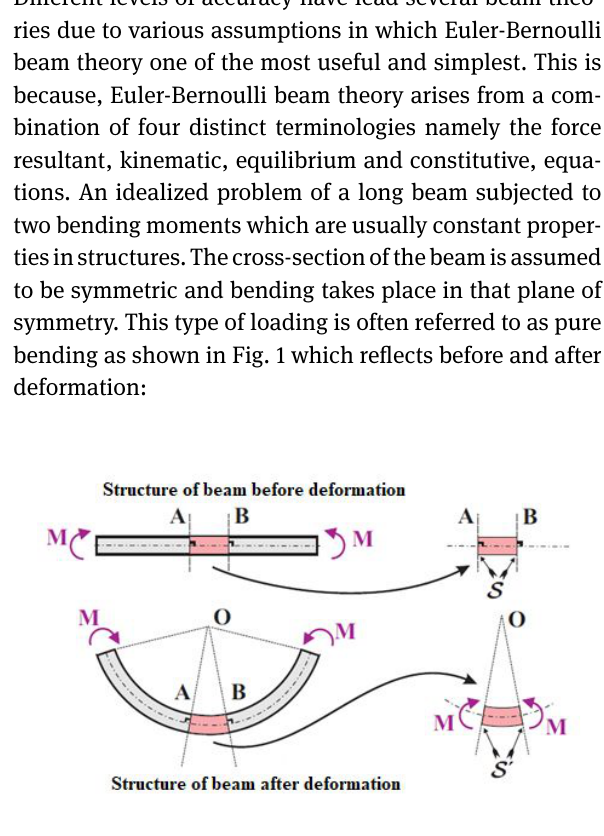
By neglecting shear deformation and rotary